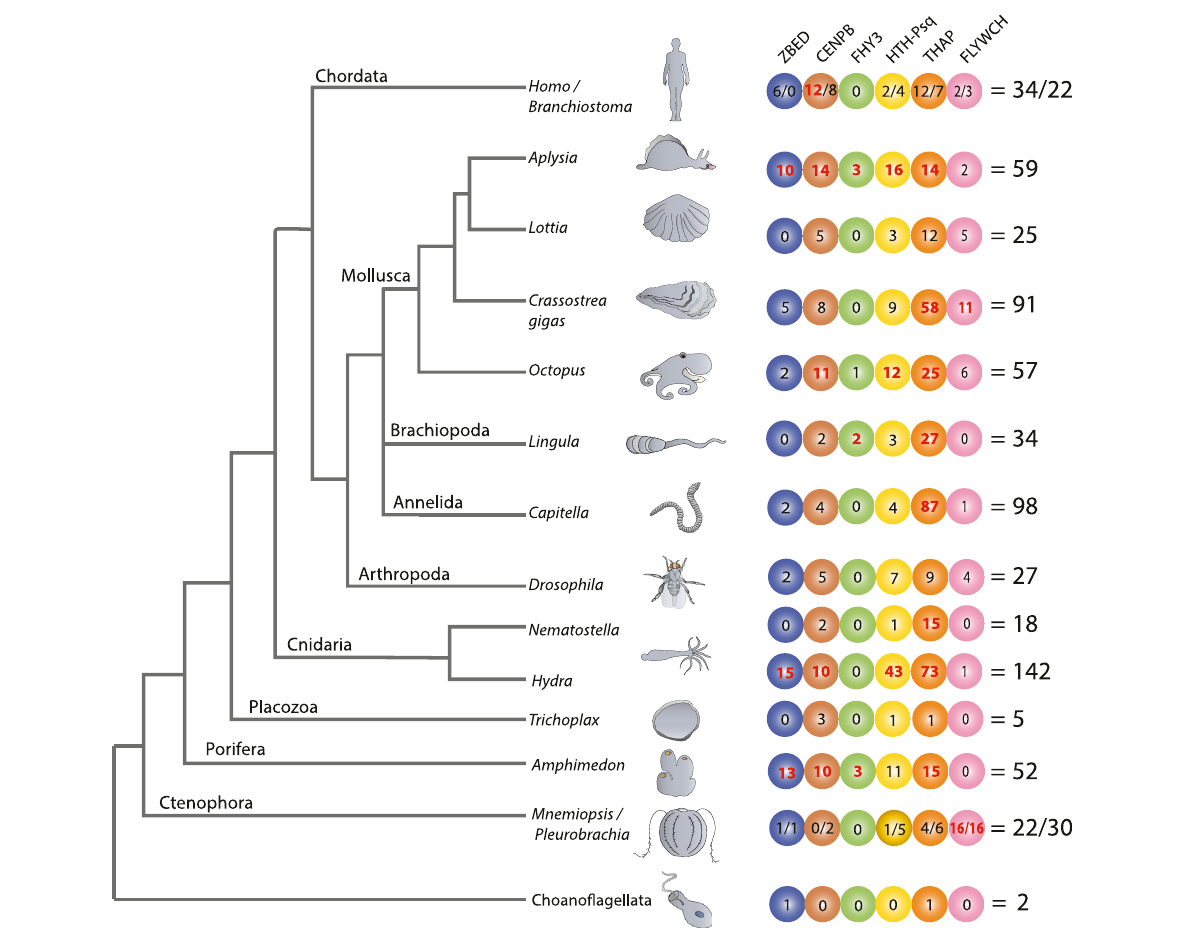
Figure 1 illuminates the mosaic-type distribution in the recruitments of transposon-derived TF subfamilies across major metazoan lineages studied here. In the sister group to all Metazoa — Choano fl agellata — we found only two genes likely encoding transposon-derived TFs from ZBED and THAP superfamilies, respectively.